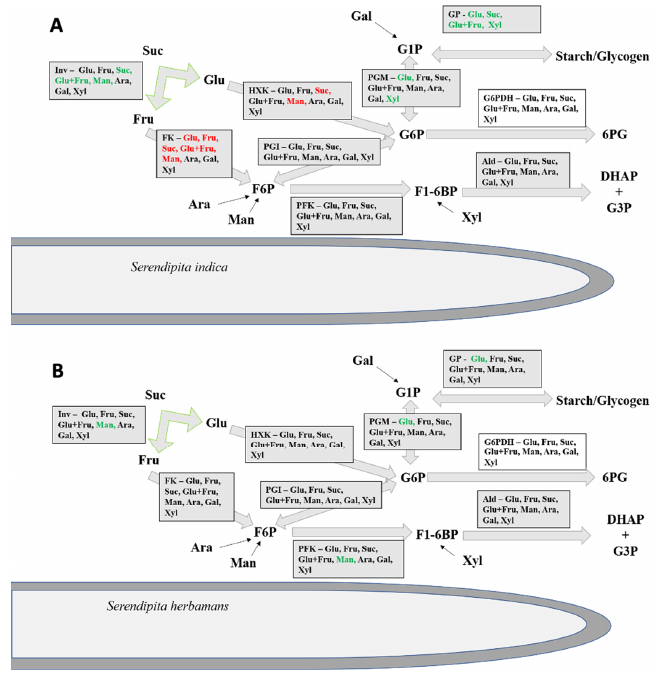
Figure 4. Extracellular carbohydrate metabolism. Model illustrating the fungal secretion of enzymes related with glycolysis. Figure represents the metabolic reactions found secreted in the external me- dium by S. indica ( A ) and S. herbamans ( B ). Plant sugars (glucose: Glu, fructose: Fru, sucrose: Suc, an equimolar mix of glucose and fructose: Glu+Fru, mannose: Man, arabinose: Ara, galactose: Gal, xy- lose: Xyl) induce (green) or repress (red) the activities of specific enzymes compared with the activ- ities of cultures grown without carbon source. Inv: invertase; FK: fructokinase; HXK: hexokinase;